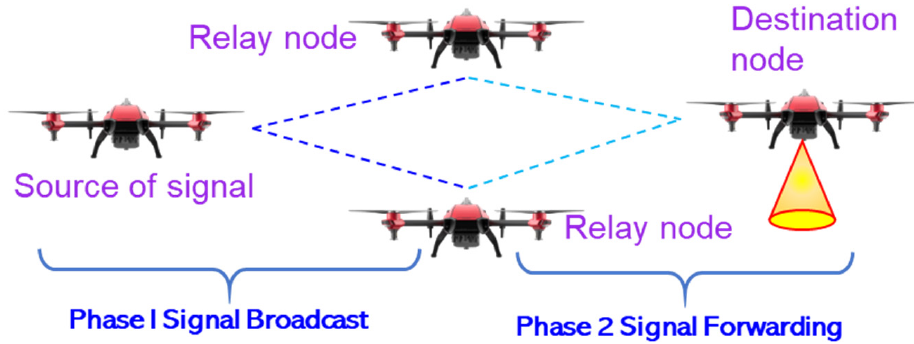
Figure 2. Signal forwarding model in cooperative communication.